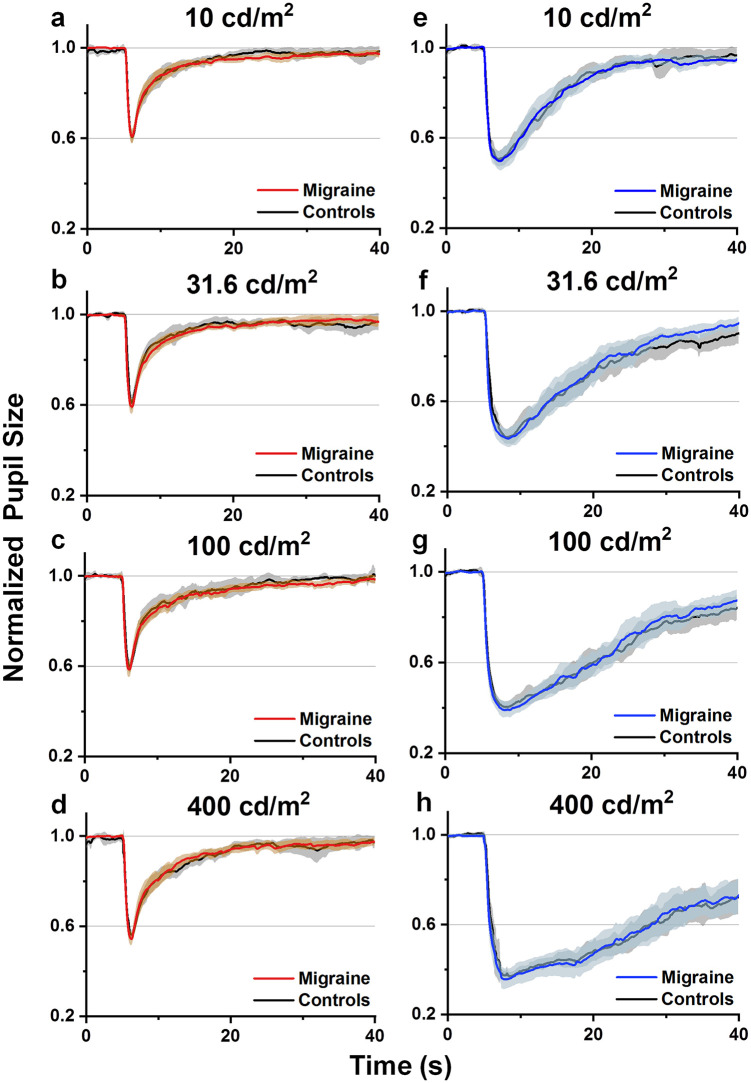
Mean normalized pupillary time courses recorded from the left eyes during simultaneous light-induced lacrimation measurements.Participants with migraine and controls were compared in response to 400 ms (a-d) red and (e-h) blue light stimulation. Error bands represent 95% confidence intervals.